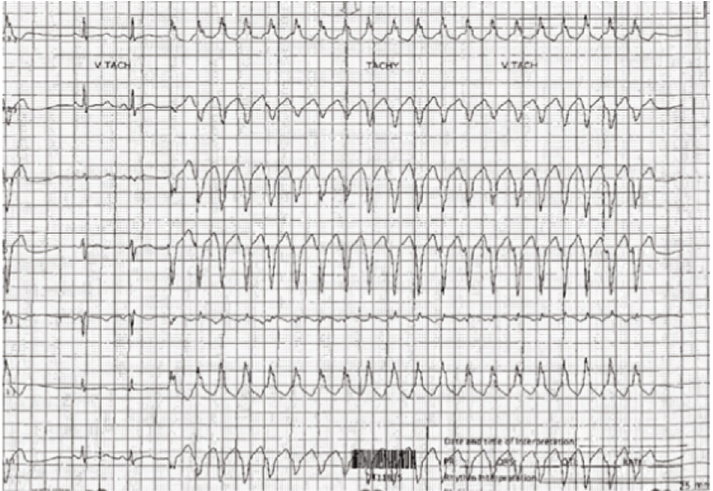
Figure 1: Nonsustained monomorphic ventricular